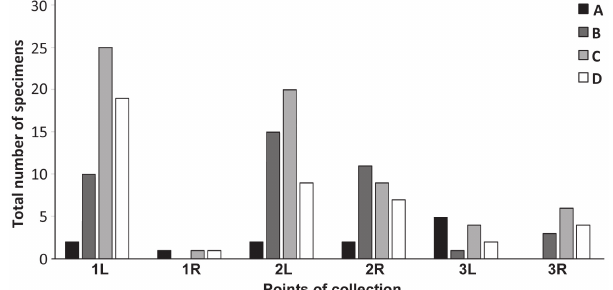
Fig. 13. Distribution of gonad maturity stages of Loricariichthys melanocheilus males in the rio Ibicuí by point of collection. 1L, 2L and 3L = Lagoon of points 1, 2 and 3 respectively, 1R, 2R and 3R = River of points 1, 2 and 3 respectively.